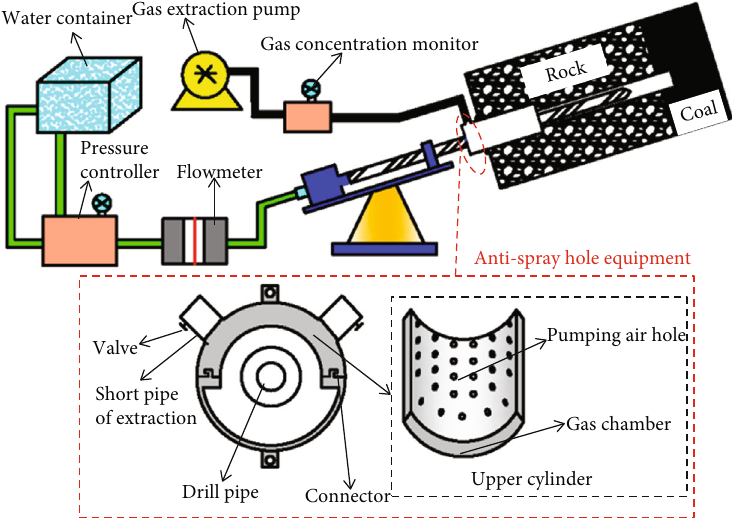
Figure 8: New type of antispray hole equipment.